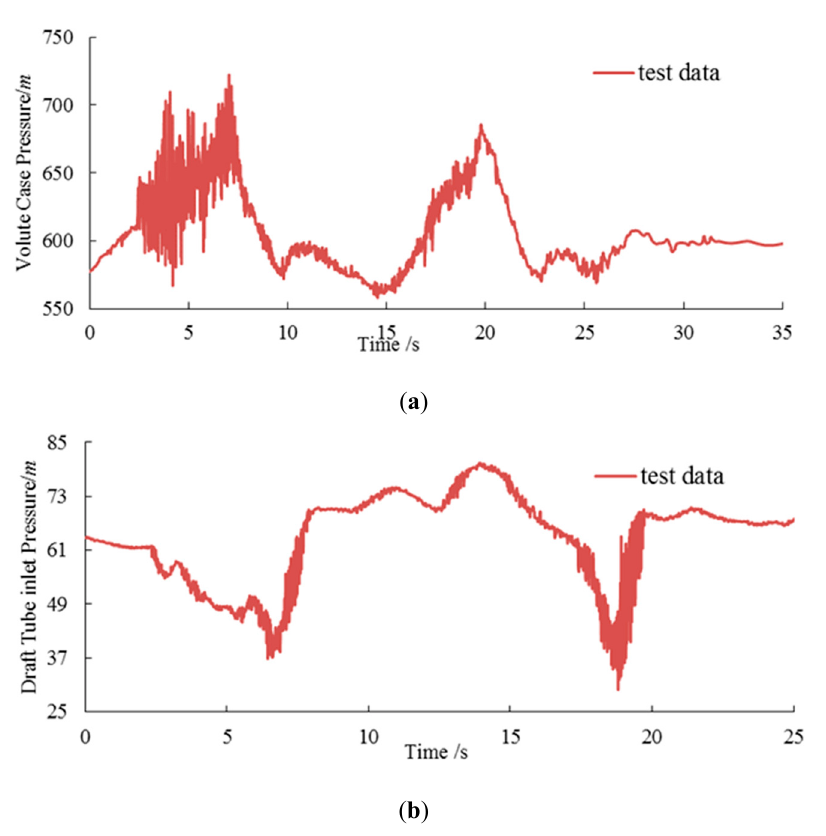
Figure 8. Filtered pressure process line: ( a ) Spiral case pressure; ( b ) Draft tube inlet pressure.